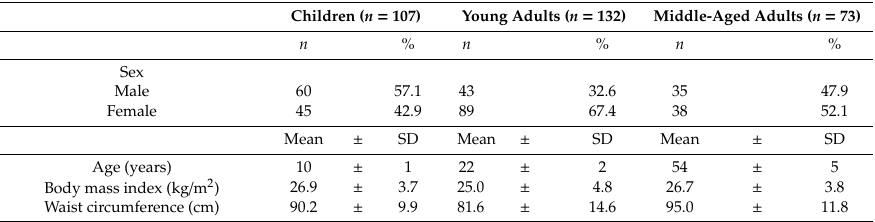
Table 1. Descriptive data of the participants.